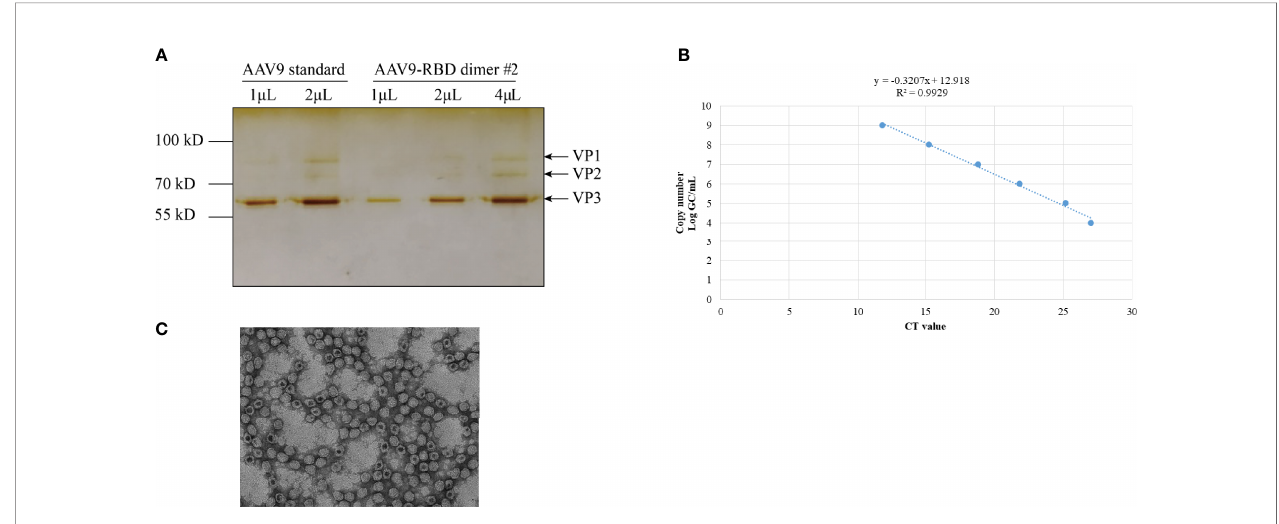
FIGURE 4 | AAV vector quanti fi cation by sliver staining and Q-PCR. The AAV vector was characterized by Silver staining (A) , Q-PCR (B) and electron microscopy (C) .